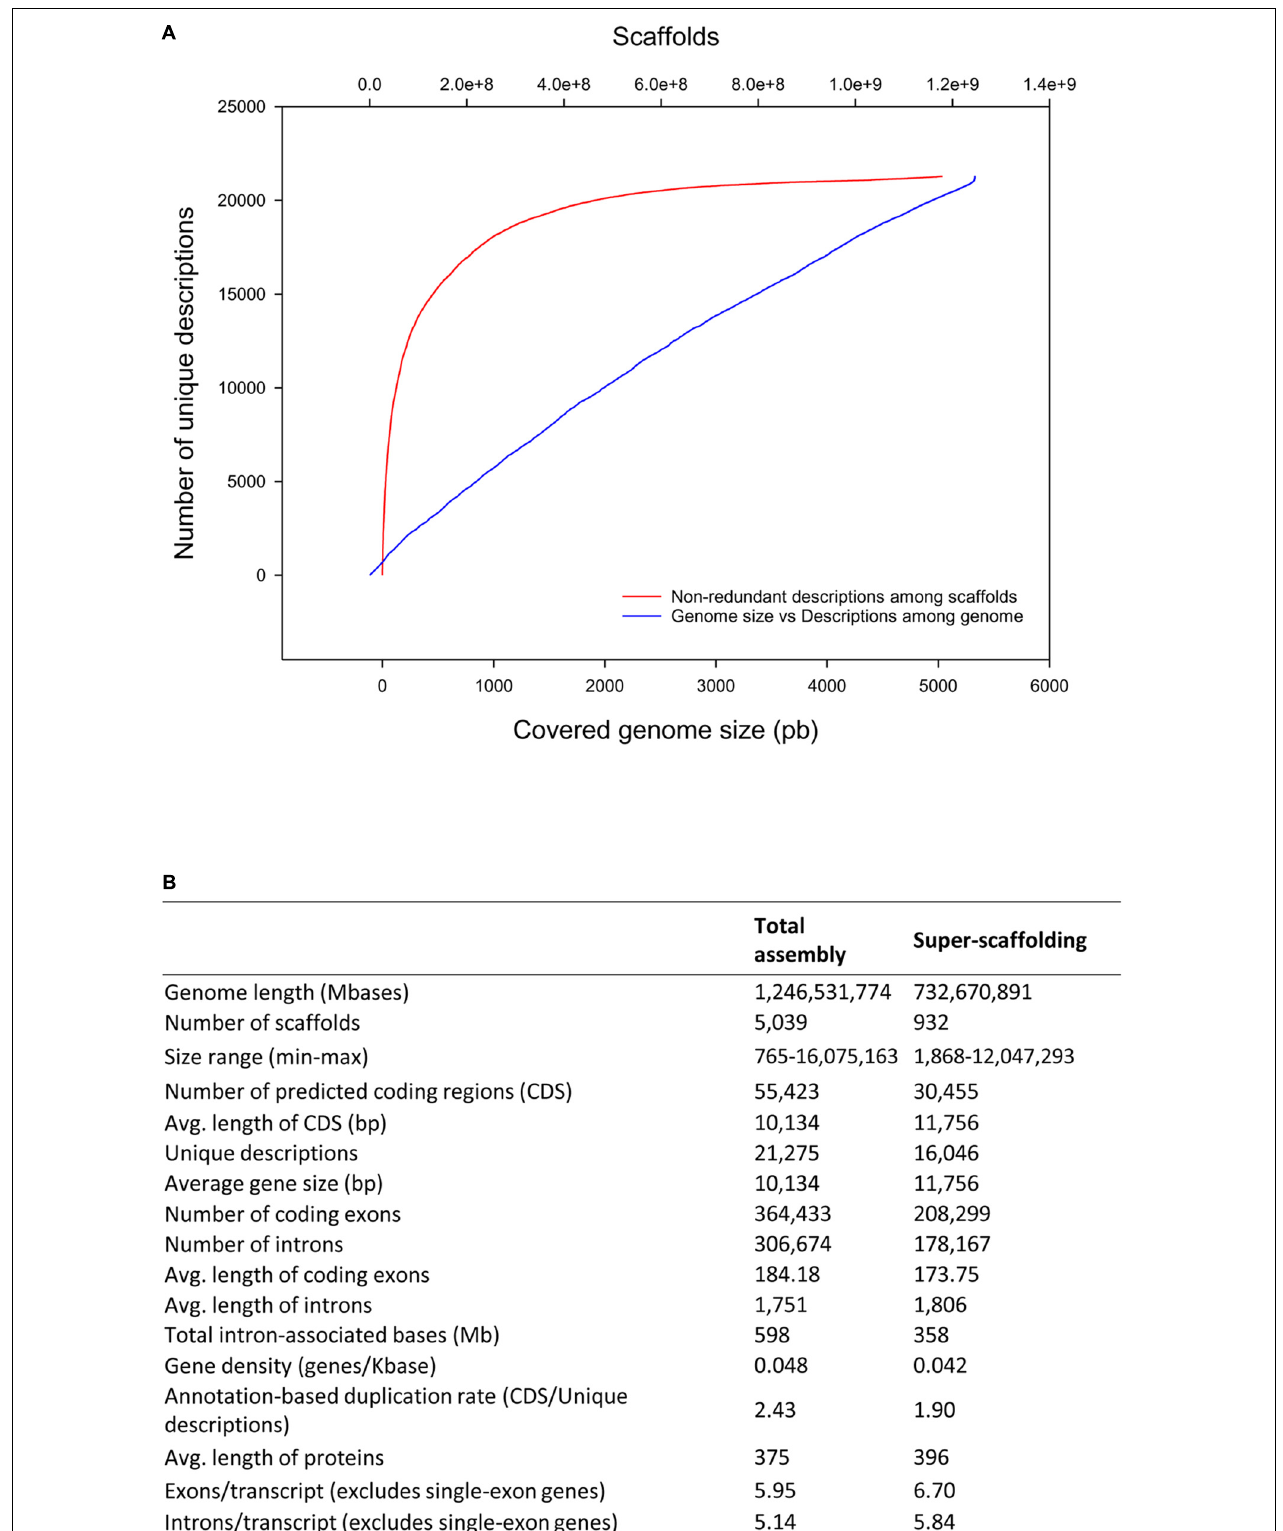
FIGURE 2 | Scaffold unique descriptions distribution and gene features. (A) Cumulative distribution of non-redundant gene annotations among length-ordered scaffolds. (B) Summary statistics of gene annotation in the gilthead sea bream genome.